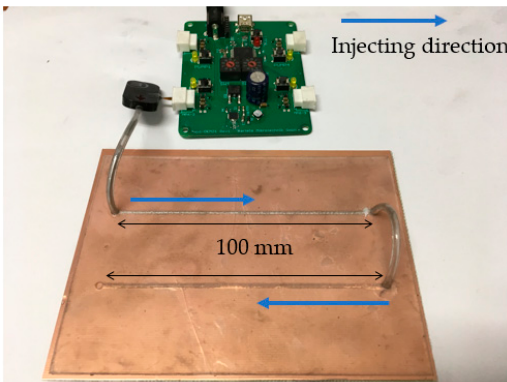
Figure 8. Test setup to measure instill rate of the proposed microfluidic channel with the micropumps and microprocessor.